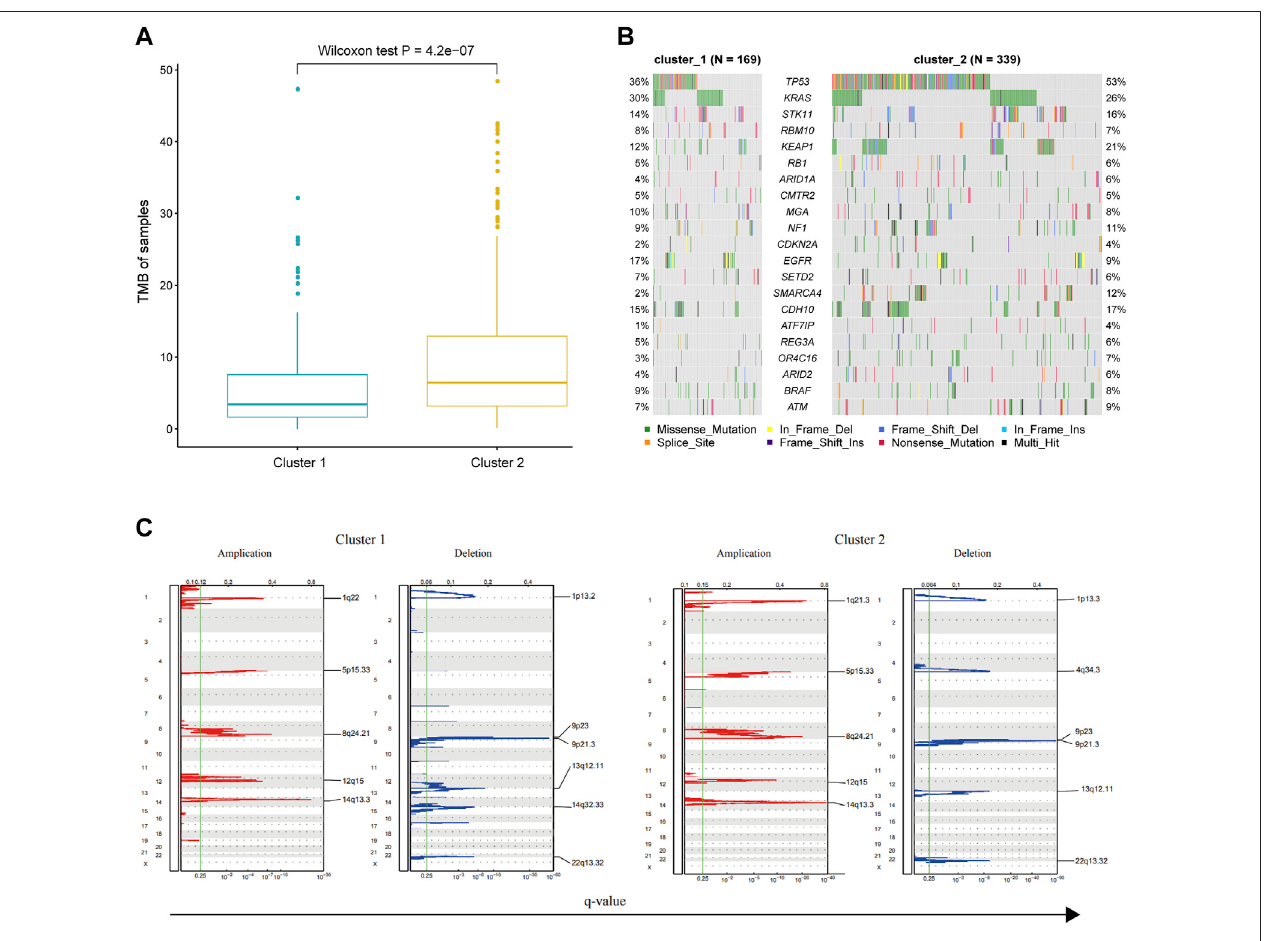
FIGURE 7 | Genomic difference between the samples of cluster 1 and cluster 2 groups. (A) TMB of tumor samples in each immune subtype. (B) Comparison of signi fi cant mutated genes in different immune subtypes. (C) Comparison of CNV, including genome implication and deletion, between two immune subtypes.